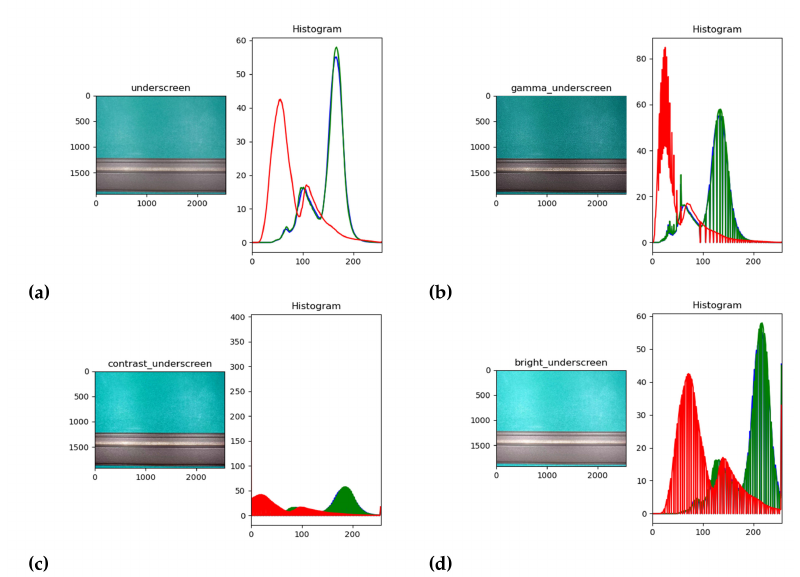
Figure 2. RGB comparison histogram for different data enhancement methods. ( a ) Original image; ( b ) gamma variation image; ( c ) contrast variation image; ( d ) brightness variation